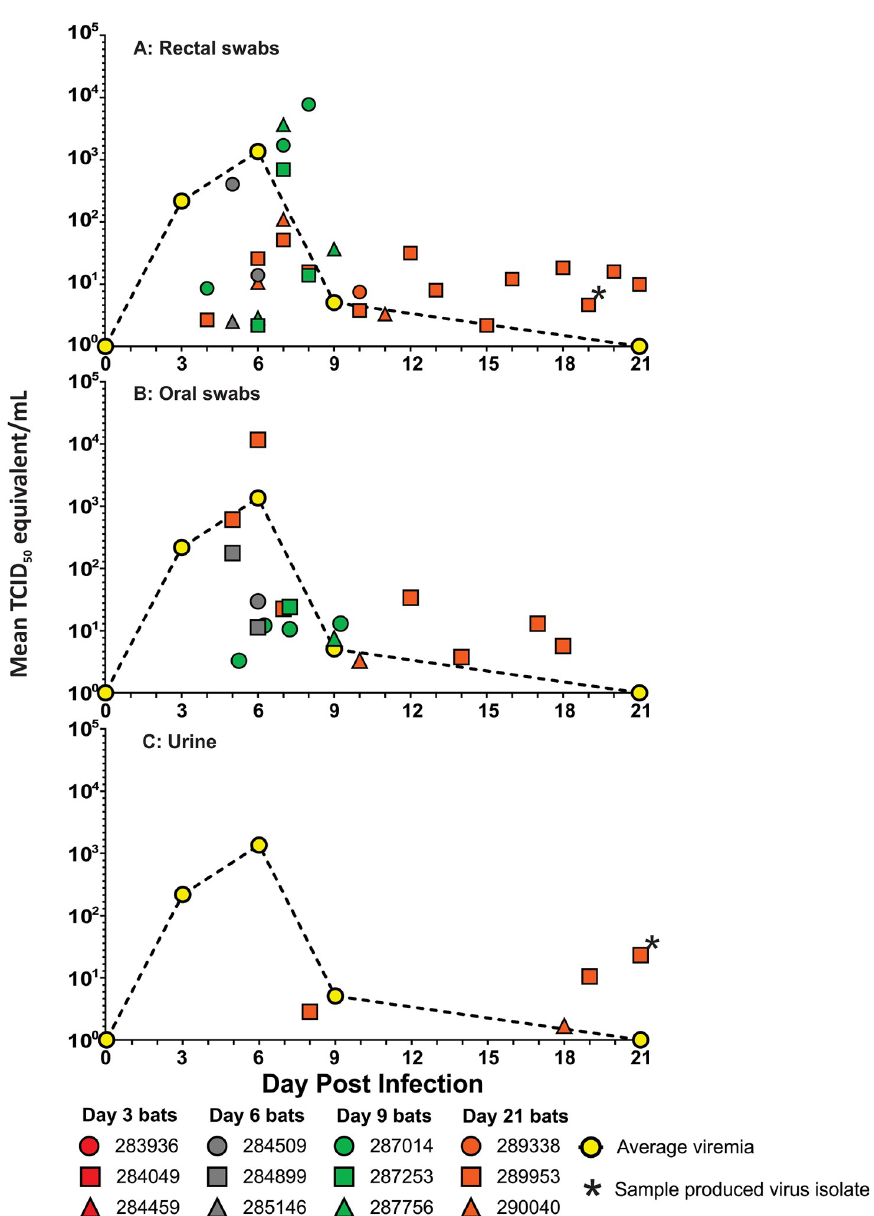
Fig 6. Sosuga virus RNA in urine and swabs (oral and rectal) from inoculated bats. Viral RNA levels (TCID 50 /mL equivalent) in (A) urine, (B) oral swabs and (C) rectal swabs by post-inoculation day. Infected bats are shown as one of three symbols (dot, square, or triangle) representing an individual bat sampled on a given day and then color coded for the day the bat was terminally sampled (red = day 3, gray = day 6, green = day 9, and orange = day 21). Swab viral levels (TCID 50 /mL equivalent) are equivalents of a SOSV stock tested (see Materials and methods), not the actual amount of virus in saliva or feces because the volume of absorbed oral secretion could not be precisely calculated. The rectal swab from which SOSV was isolated (panel A) is represented by an asterisk ( � ) by an orange square on day 19. Similarly, the SOSV isolate from a urine sample (panel C) is represented by an asterisk ( � ) by an orange square on day 21. For reference, the mean viral loads detected in blood from the bats euthanized on days 3, 6, 9, and 21 are shown as a dashed black line with yellow dots.